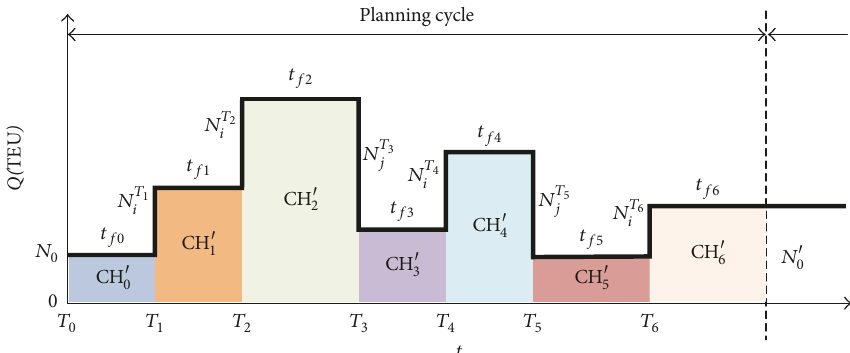
Figure 2: Schematic diagram of calculation on total container-hours in coordination